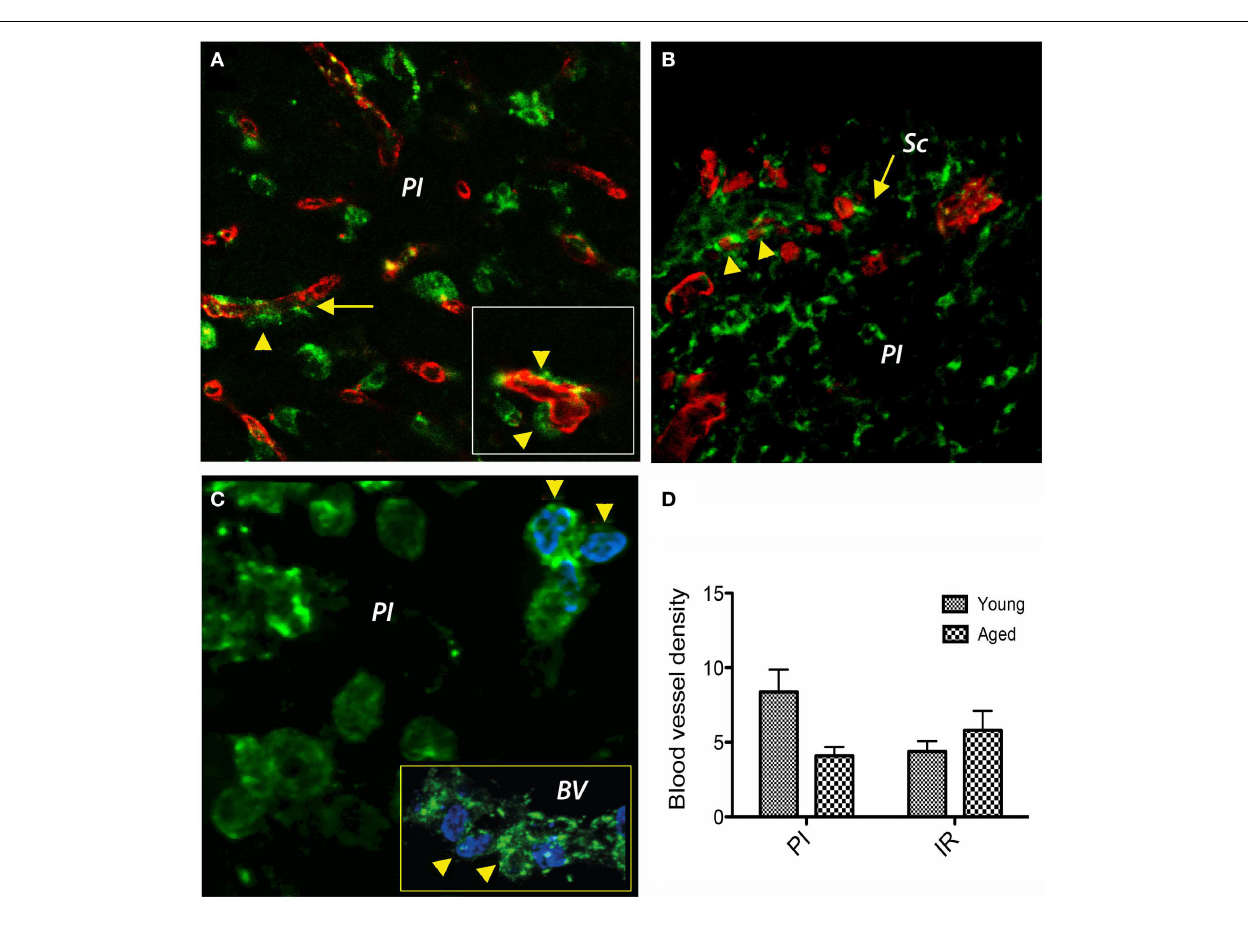
marker BrdU (blue) in aged rat brains revealed that some proliferating fibrocytes/fibroblasts had BrdU-positive nuclei in the peri-lesional area (arrowheads). Eventually, some co-labeled cells emanated from the capillary wall [ (C) , inset, arrowheads]. (D) At day 14 post-stroke, the vascular density was higher in the peri-infarcted area of young animals as compared to the similar region of aged rats (twofold). However, beyond the inhibitory fibrotic scar, the vascular density was similar in the two age groups. (A–C) represent Z -projection